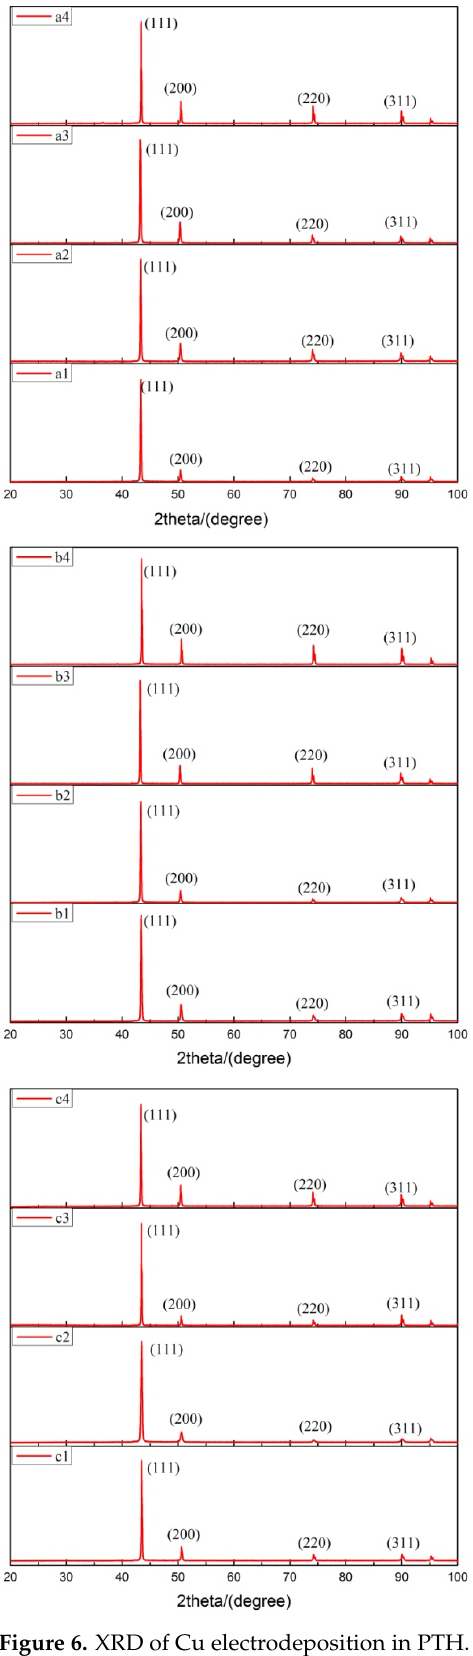
Figure 6. XRD of Cu electrodeposition in PTH. ( a1 – a4 ) is reverse pulse frequency (HZ). ( b1 – b4 ) is reverse pulse duty cycle. ( c1 – c4 ) is reverse pulse current density (A/dm 2